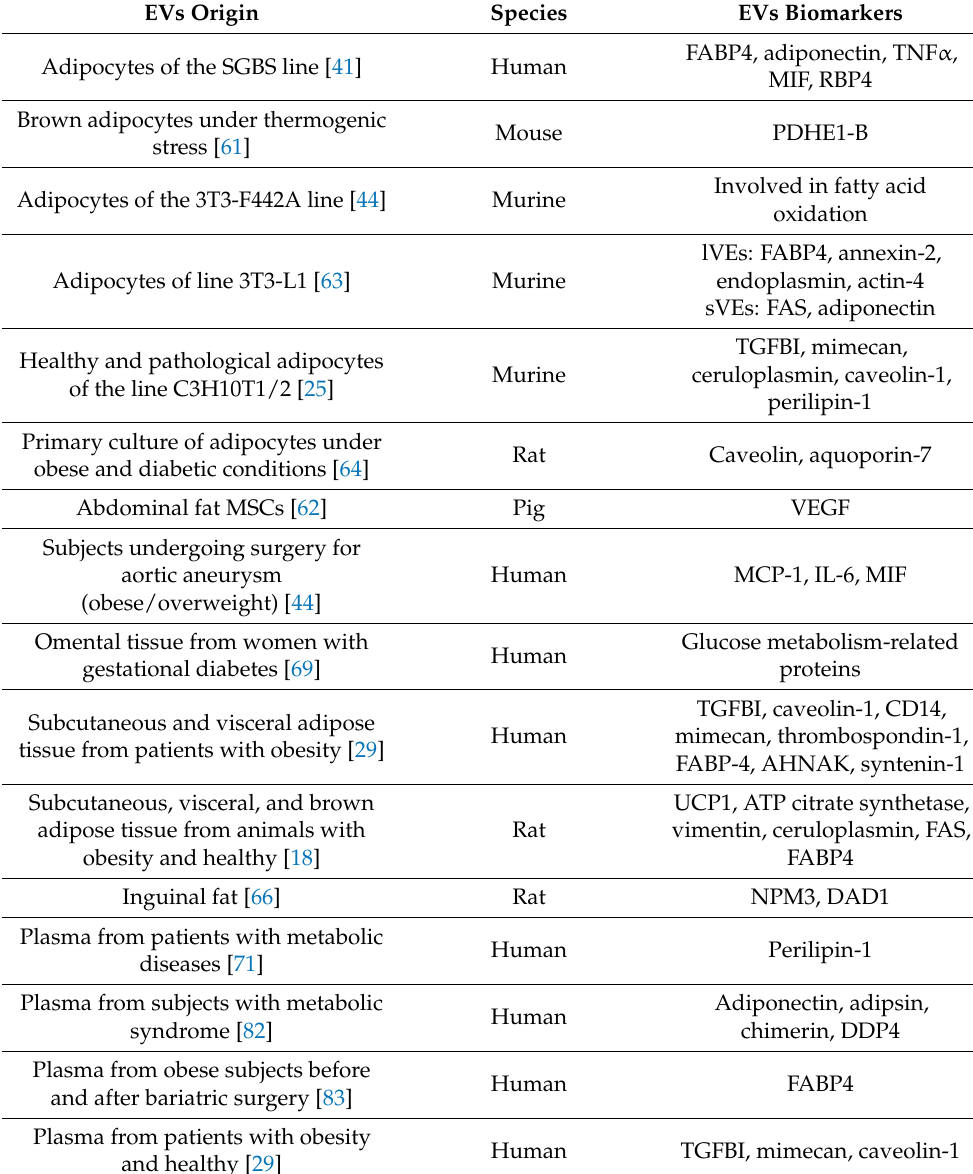
Table 2. Overview of the reviewed publications related to the characterization of the protein load of EVs from adipose tissue or at the circulating level; origin, species, and EVs-biomarkers function. EVs